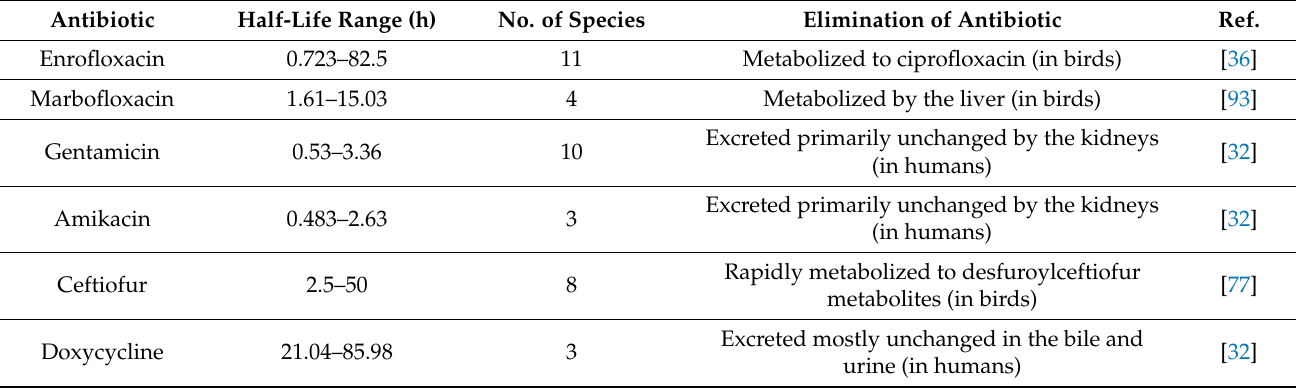
Table 14. Half-life ranges of enrofloxacin, marbofloxacin, gentamicin, amikacin, ceftiofur, and doxy- cycline in exotic avian